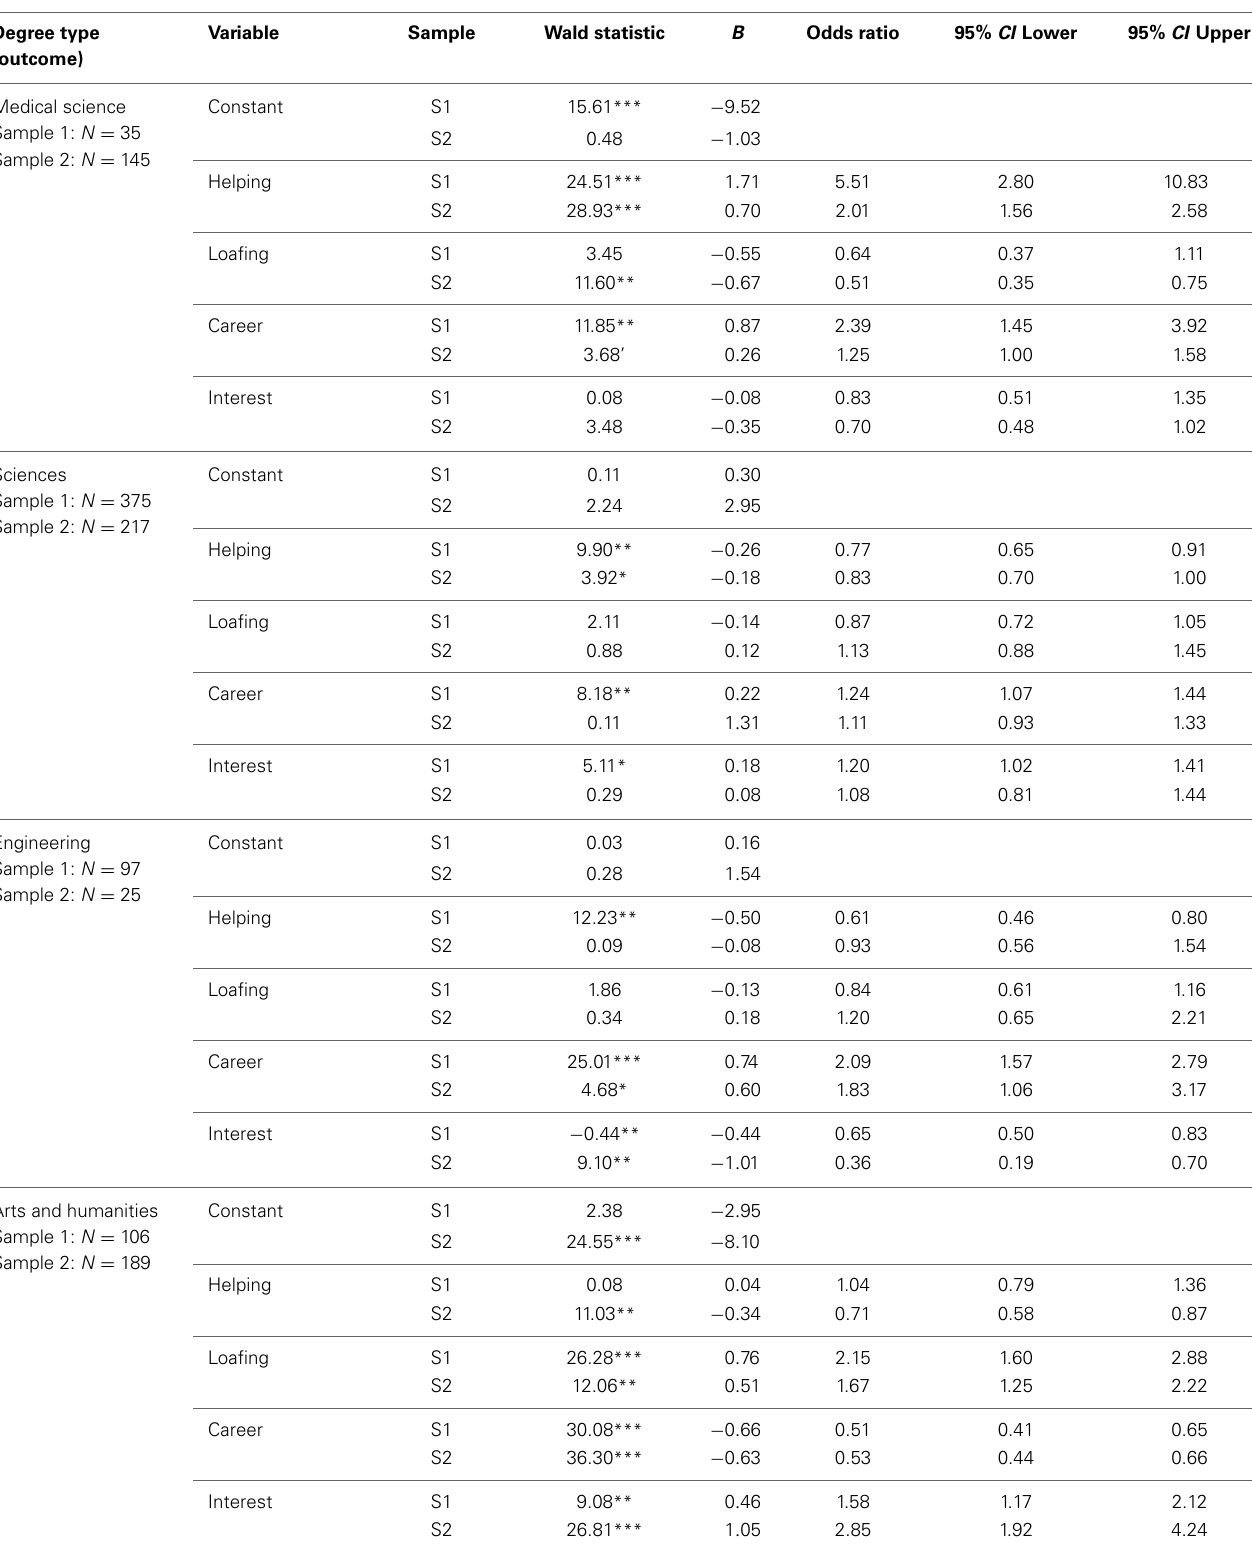
Table 4 | Logistic regression models predicting degree types (Wald statistic, unstandardized B , odds ratio and respective confidence intervals for the MICC scales, Step 3 of regression analyses, see Table 5 for clarification), Sample 1 (S1, undergraduates, N = 844) and Sample 2 (S2, prospective students, N =